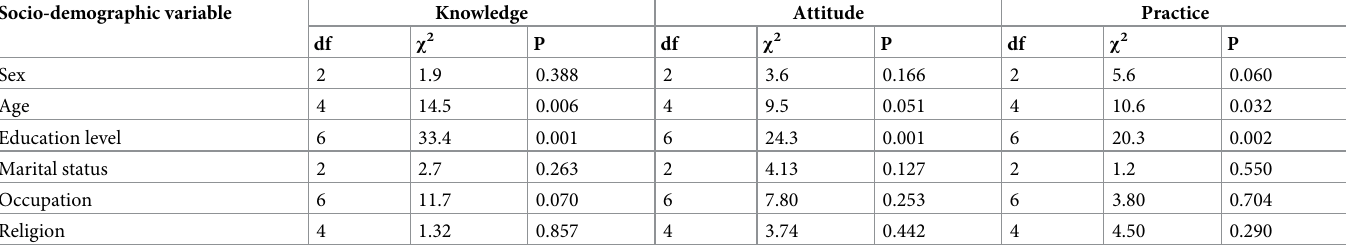
Table 11. Association between sociodemographic variables and knowledge, attitude, and practice of the farmers or farm workers on the factors contributing to the AMR. Socio-demographic